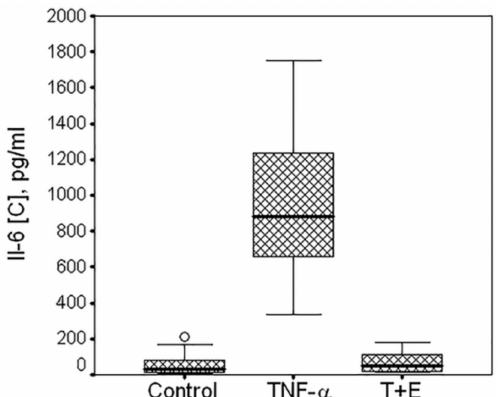
Figure 3. Box plot of the TNF- α -mediated expression of IL-6 by cartilaginous cells isolated from 10 donors. Data are from multiple experiments. Horizontal line in the box plot indicates median, low and upper borders of the box are quartiles. IL-6 production was measured in the medium of untreated cells (control), or cells treated with TNF- α (TNF- α ) or with mixture of TNF- α and etanercept (T + E). Multiple comparisons (Dunnett T3 test) showed highly significant di ff erences between control and TNF ( p < 0.001); between TNF an TNF + E ( p < 0.001); no di ff erence between control and TNF + E ( p =